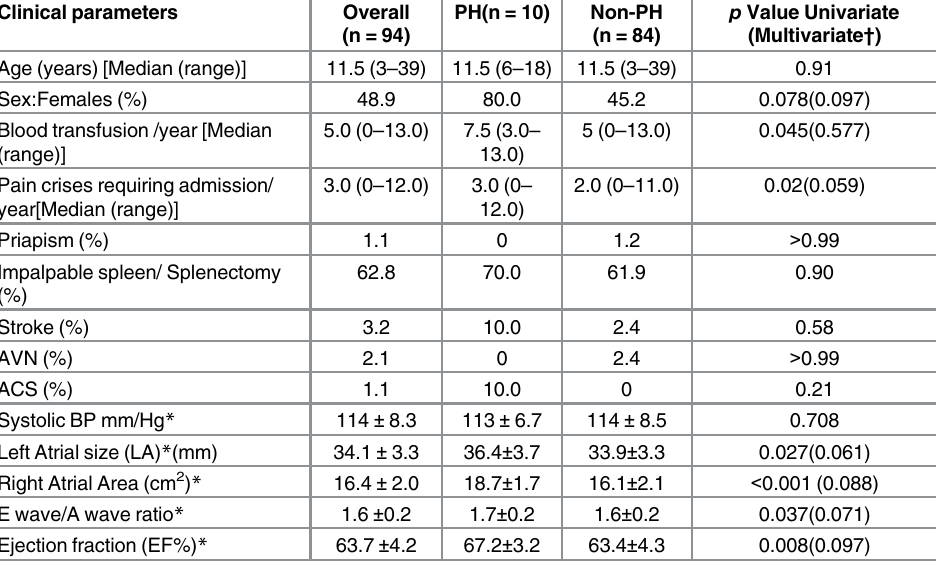
* Mean ± SD; AVN: Avascular necrosis of femoral head; ACS: Acute Chest Syndrome; † p values for multiple logistic